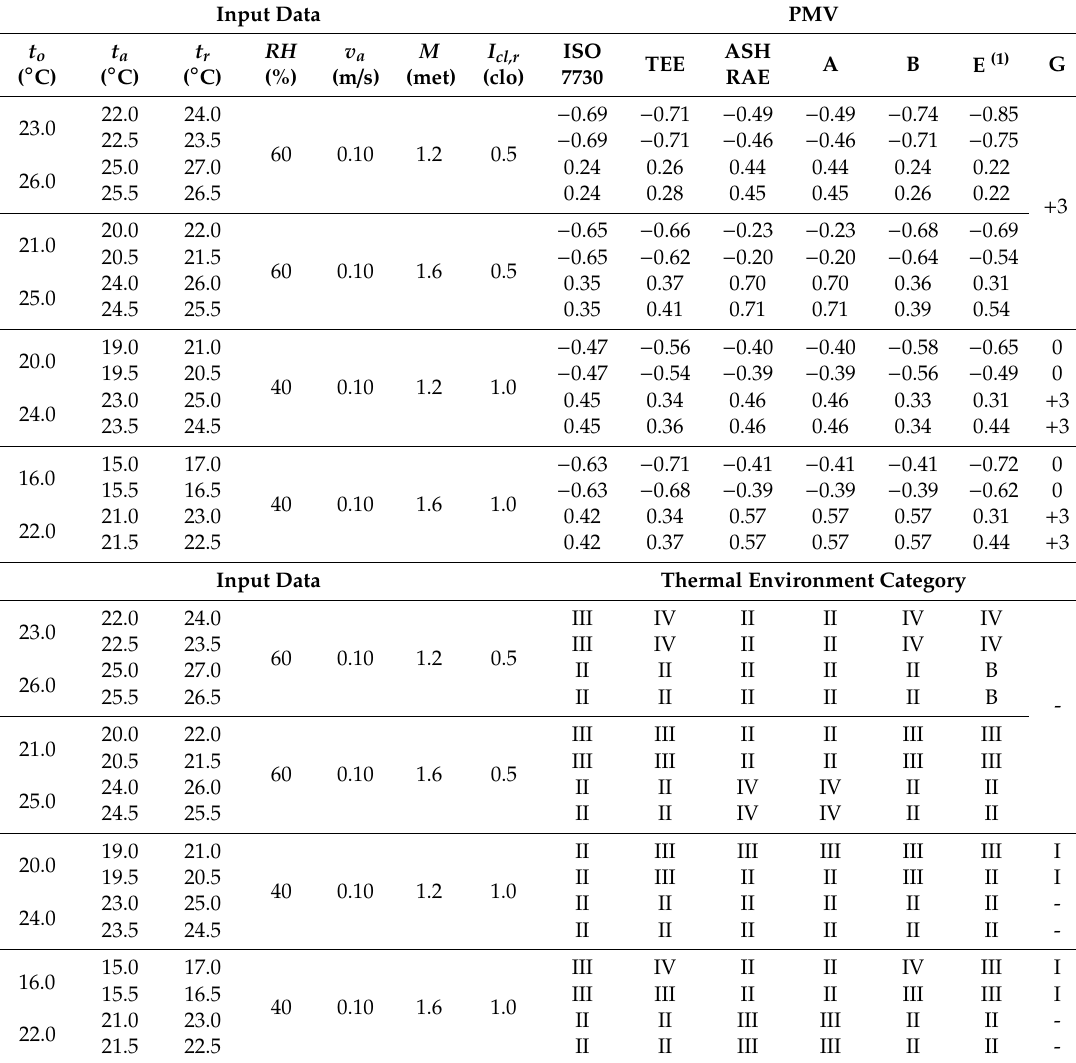
Table 7. PMV values and comfort categories obtained with the investigated software and comparison with values from ISO 7730 tables for the operative temperature values in Table 6 with ( t r – t a ) values of 1 ◦ C and 2 ◦ C. Apps C and D were not considered as they allow only one data input value for the temperature. (1) PMV value has been calculated by means of Equation